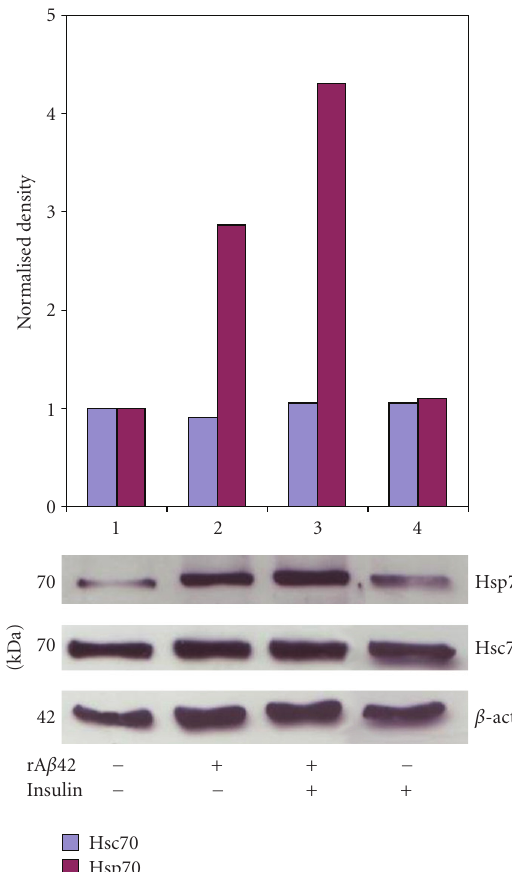
Figure 5: Insulin enhances inducible Hsp70 activation triggered by rA β 42 oligomers. Western blot of proteins extracted from LAN5 untreated (1), treated with rA β 42 oligomers (40 μ M) for 1 h (2), rA β 42 oligomers (40 μ M) for 1 h and insulin (100 μ M) for 20 h (3), insulin alone (100 μ M ) for 20 h (4), incubated with anticonstitutive Hsp70 (Hsc70), antiinducible Hsp70 (Hsp70) or beta-actin ( β - actin). Uniformity of gel loading was confirmed with β -actin as standard. Quantification of immunoreactivity was performed using densitometric